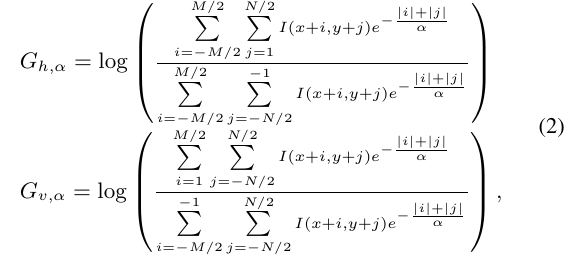
Figure 3. (a) The reference image (b) L-shape detection of the reference image (c) L-shape reconstruction of the reference image (d) The sensed image (e) L-shape detection of the sensed image (f) L-shape reconstruction of the sensed